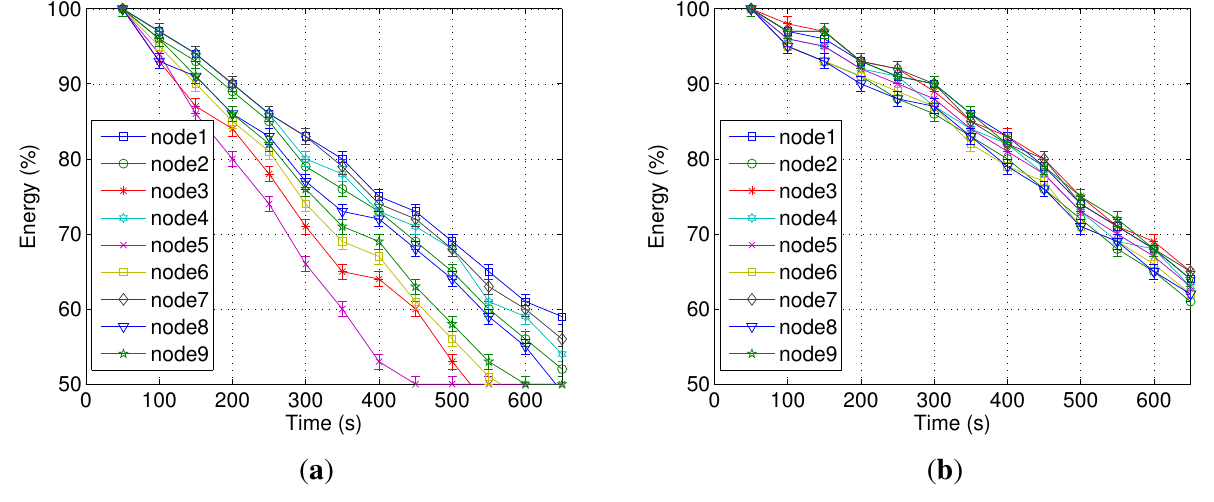
Figure 7. Network lifetime in testbed experiments. ( a ) AODV, ( b )